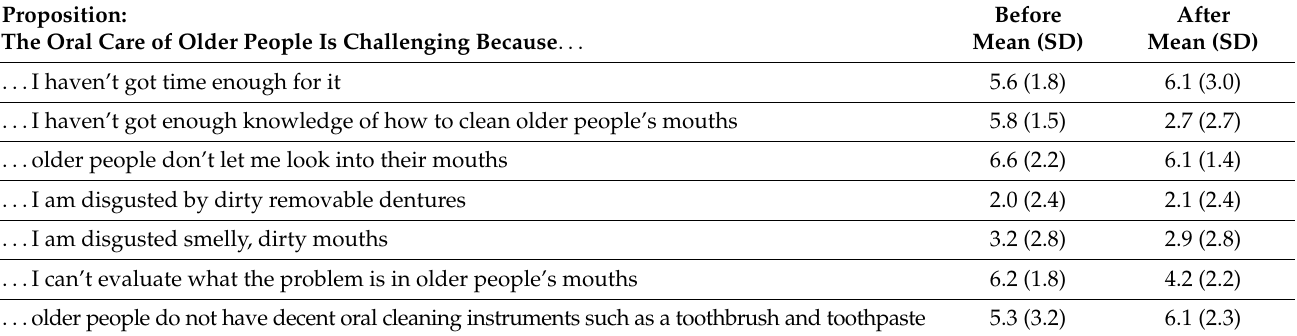
Table 4. Mean scores for challenges items before and after